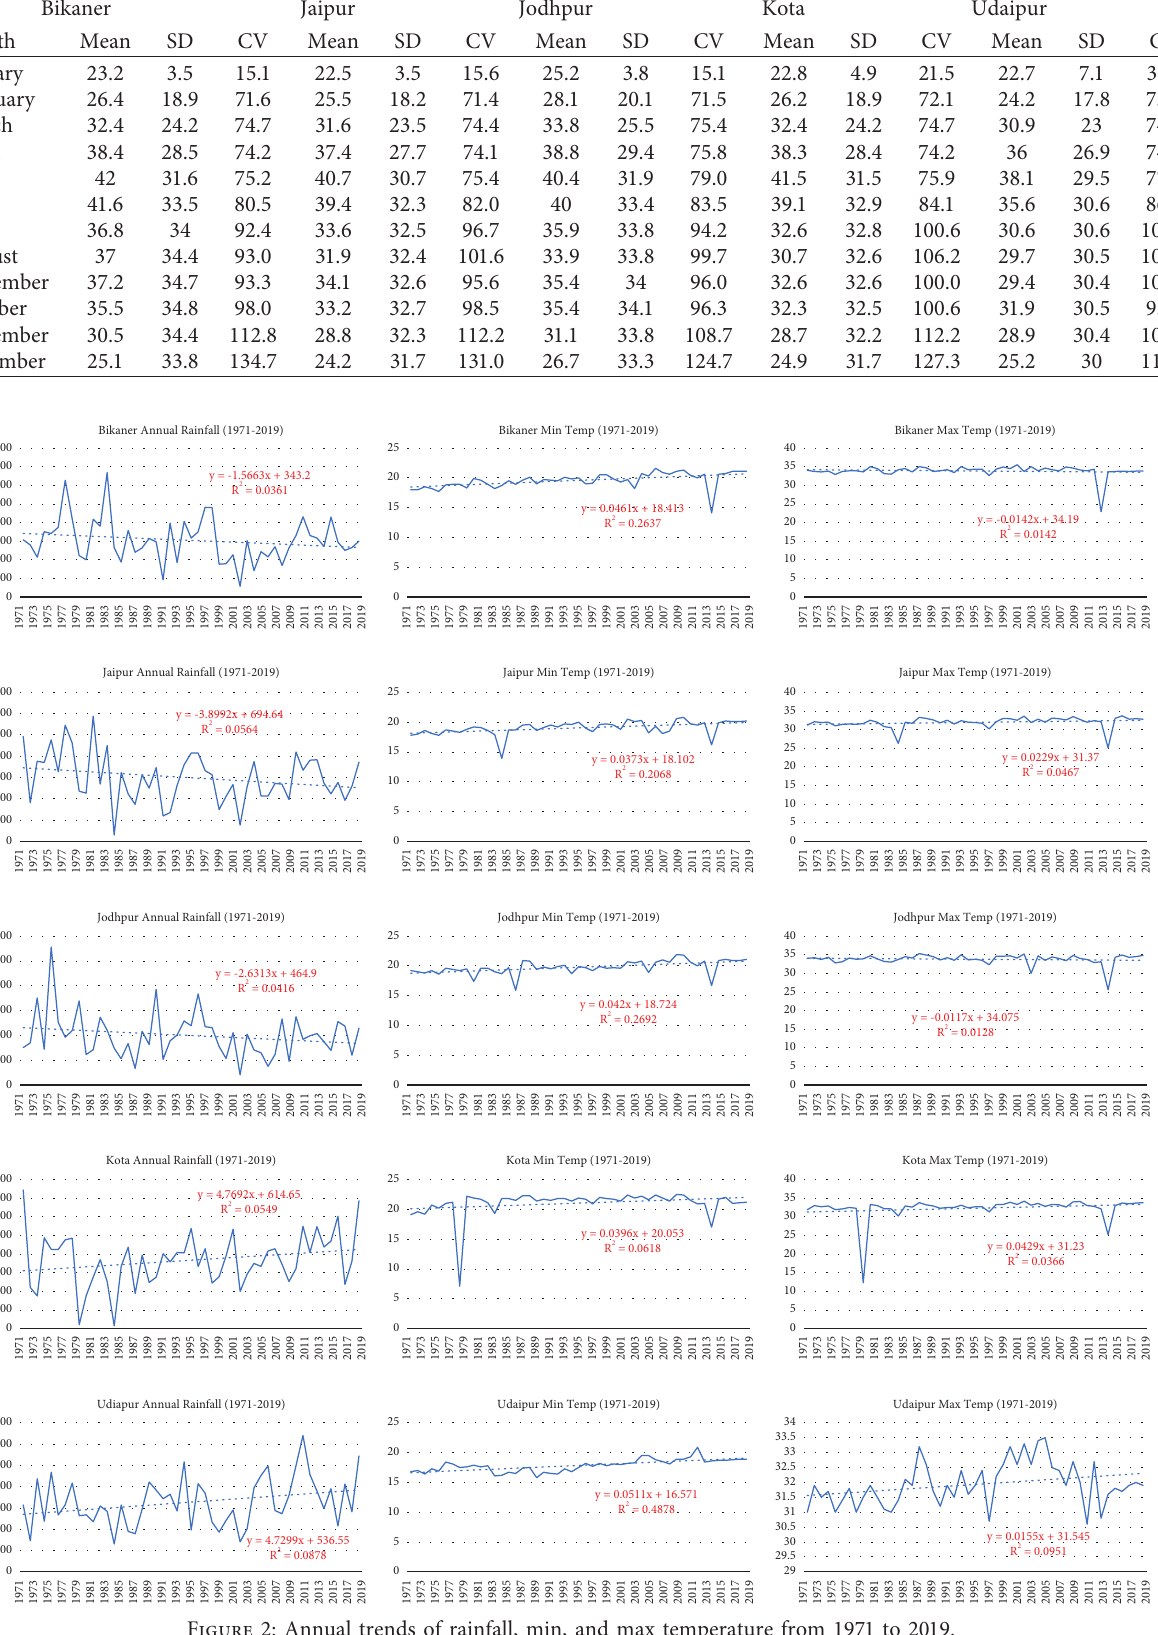
Table 4: Summary statistics for max temperature in C (1971–2019) in the districts of Rajasthan. Bikaner